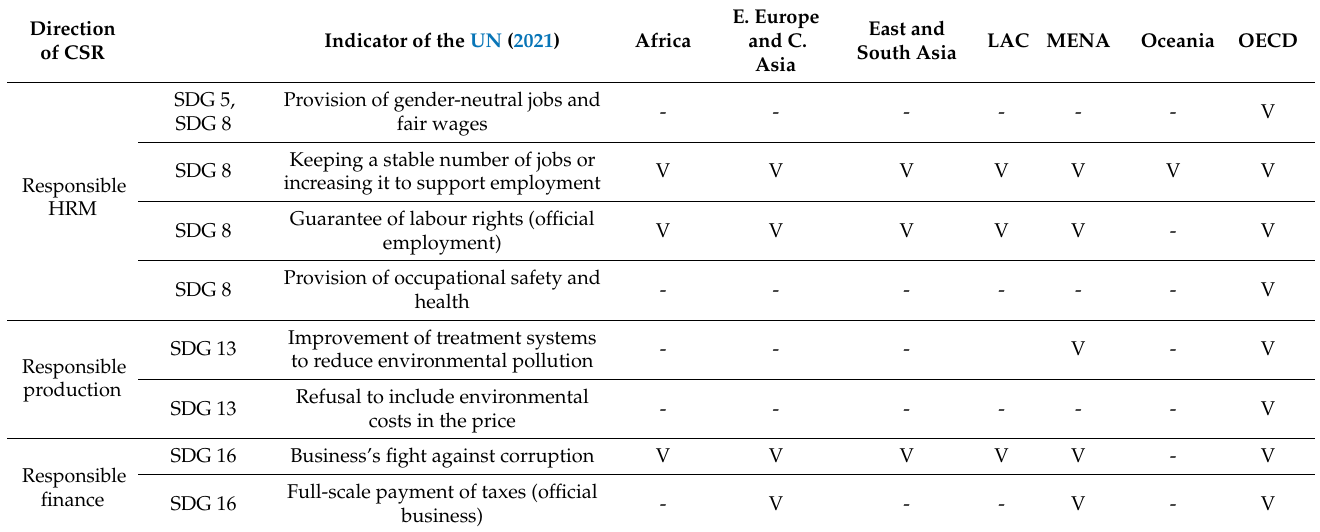
Table 11. Specific measures of corporate social responsibility to support the SDGs that are imple- mented in regions of the